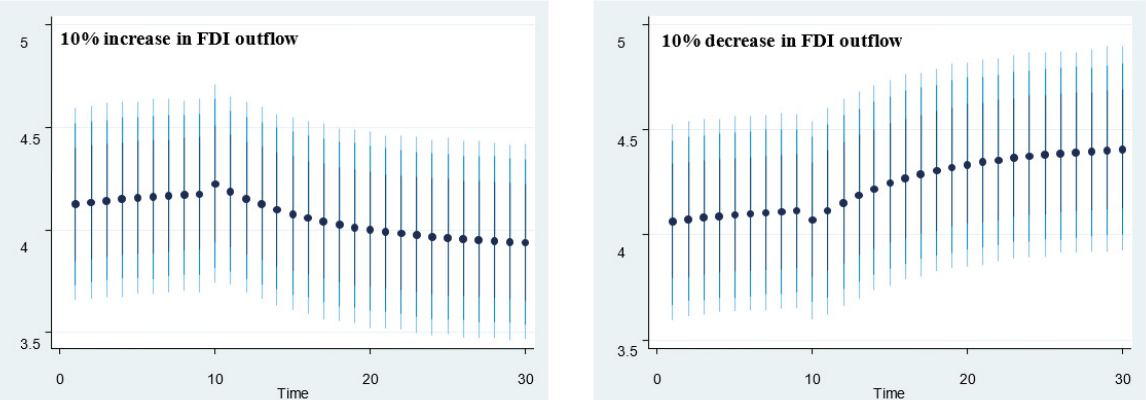
Figure 4. Outward FDI flows and domestic investment. The above graphs portray ±10% in the outward FDI flow and its impact on domestic investment. The dots depict the average prediction value, while the dark blue to light blue lines indicate 75%, 90%, and 95% confidence interval, respectively.